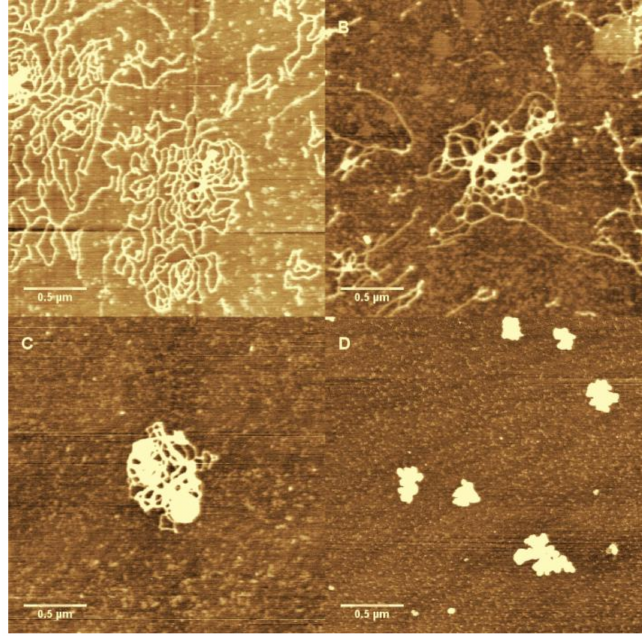
Figure 8. The AFM images of DNA condensation induce by Co 3+ . The concentration of Co 3+ is 0.01 mM ( A ); 0.06 mM ( B ); 0.15 mM ( C ); and 0.2 mM ( D ). DNA morpgologies by hydrolysed metal ions show the simple coil–globule transition. However, some proteins like chromatin structural protein CTCFT are able to induce DNA to form more complex structure such as compact circular complexes, meshes, and networks